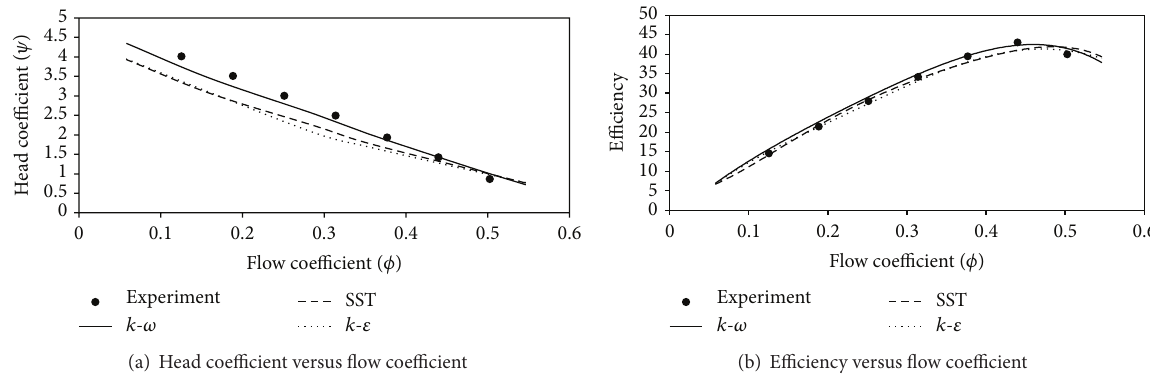
Figure 7: Comparison of regenerative pump performance curves obtained from numerical simulations with experimental data.